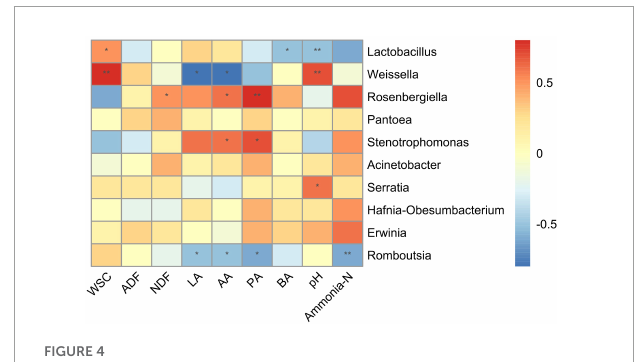
FIGURE4 Correlation analysis between the bacterial community at genus level and fermentation products. WSC, water-soluble carbohydrates; NDF, neutral detergent fiber; ADF, acid detergent fiber; LA, lactic acid; AA, acetic acid; PA, propionic acid; BA, butyric acid. The corresponding value of heatmap is the Spearman correlation coefficient r ( − 1 to 1), a value above 0 indicates a positive correlation (red), a value below 0 shows a negative correlation (red), ∗ p < 0.05 and ∗∗ p <